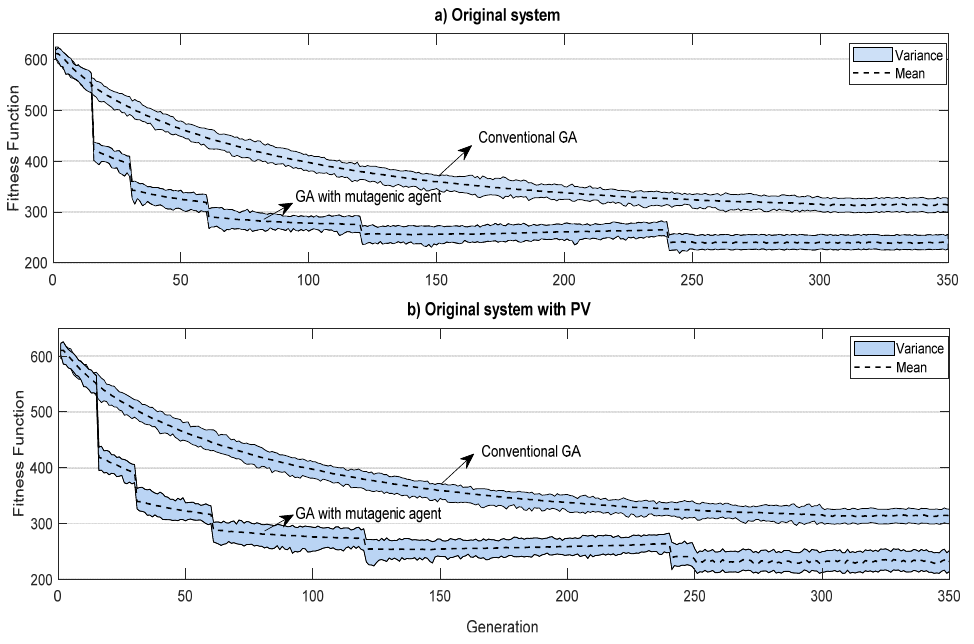
Figure 14. Mean and variance of best solutions using conventional GA and proposed GA with the mutagenic agent. ( a ) Original system. ( b ) Original system with PV generations.